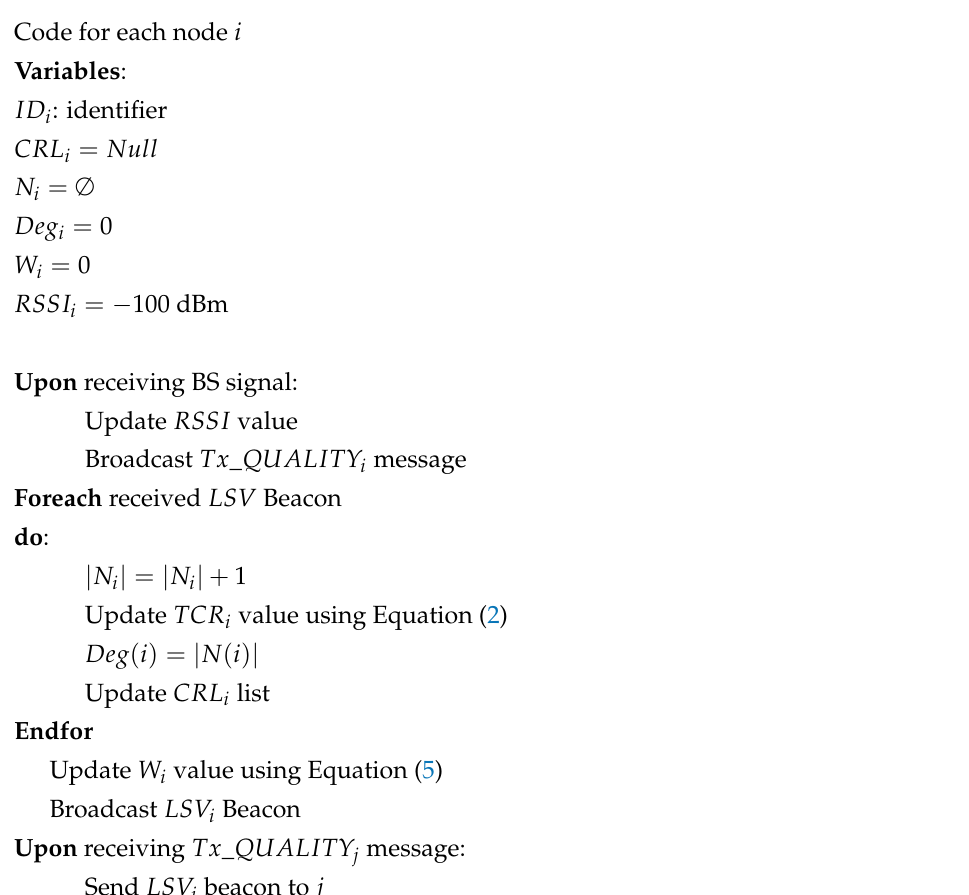
Algorithm 1 Initialization